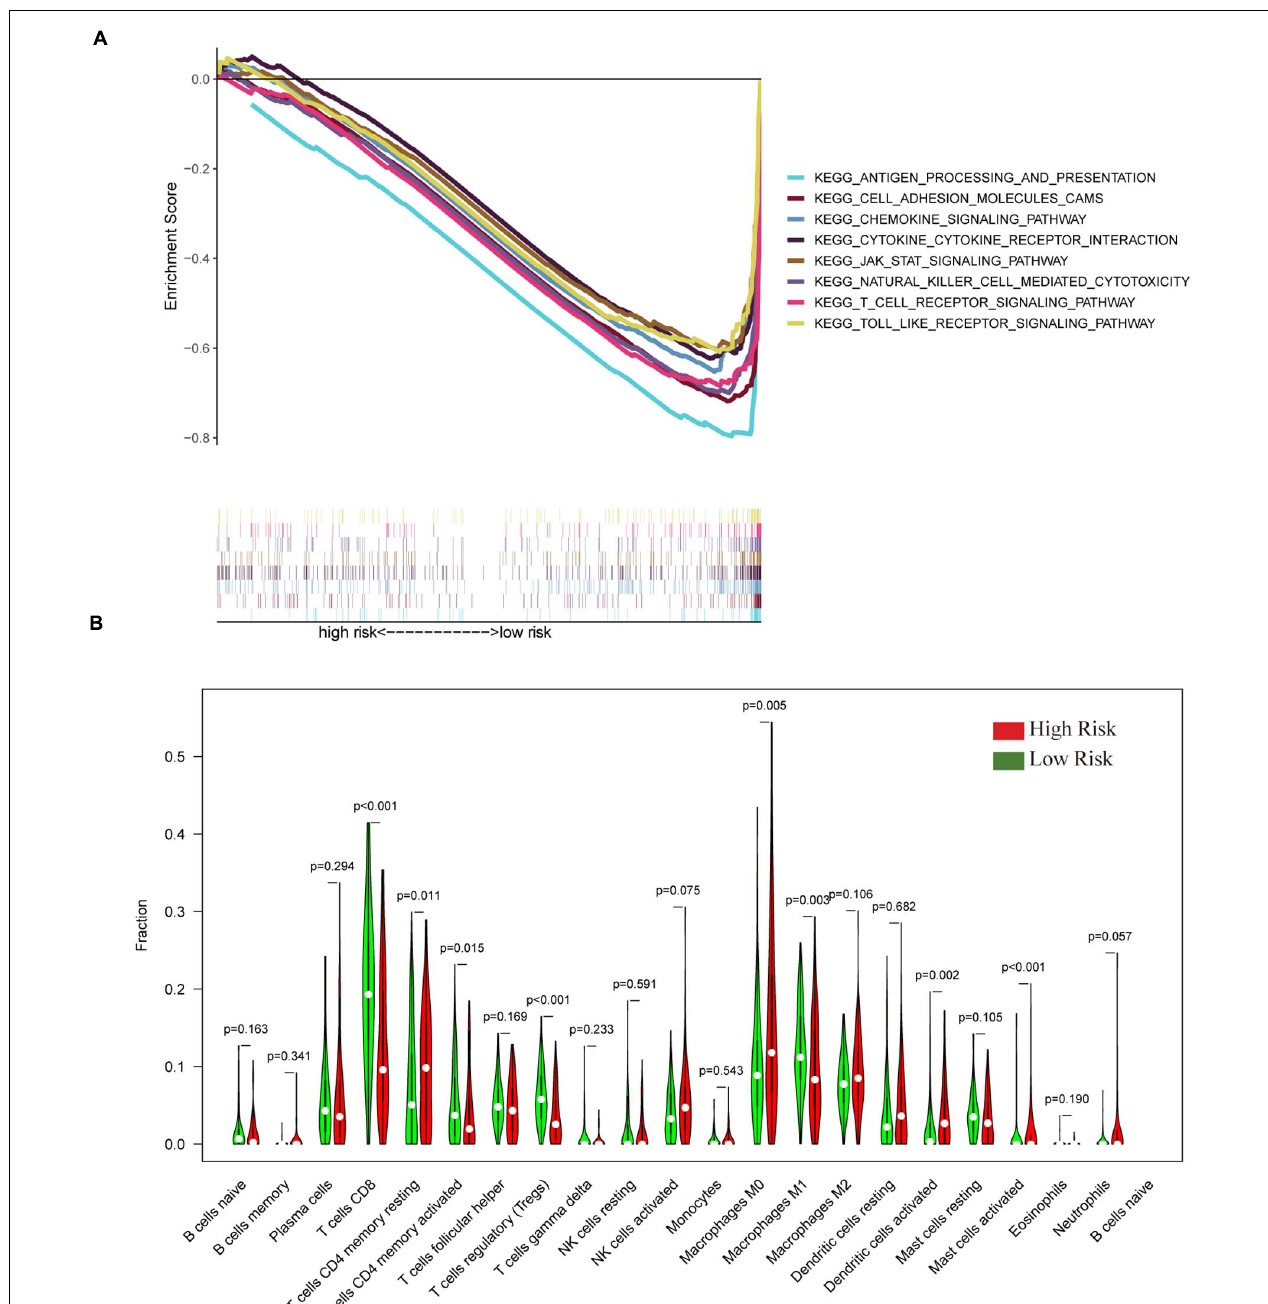
FIGURE 6 | The gene set enrichment analysis (GSEA) and tumor-infiltrating immune cells (TIC) profiles in CC samples classified into high- and low-risk groups. (A) Enriched gene sets in C2 collection, the KEGG gene sets, by samples of low-risk. Each line represents a particular gene set with unique color, and upregulated genes are located on the left approaching the origin of the coordinates. In contrast, the downregulated genes are located on the right of the x-axis. Only gene sets with both nominal p < 0.05 and FDR q < 0.05 were considered significant. Several top gene sets are shown in the plot. (B) The violin plot showed the ratio differentiation in 21 types of immune cells between CC tumor samples with high or low risk relative to the median of the risk score; the Wilcoxon rank-sum test was applied to assess the statistical